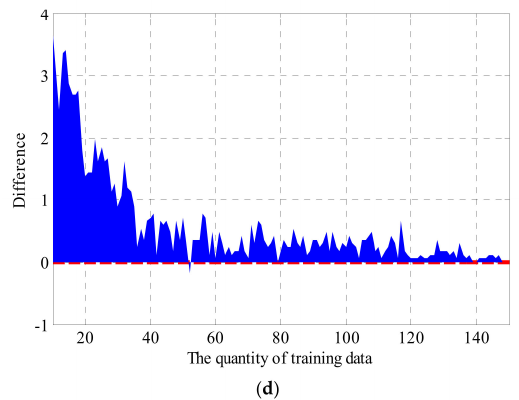
Figure 19. The Overall accuracy (OA) difference of different classification cases: ( a ) case 1: OA difference of 4-category classification for GWC A, B, C and D; ( b ) case 2: OA difference of 2-category classification for GWC A and B; ( c ) case 3: OA difference of 2-category classification for GWC B and C; ( d ) case 4: OA difference of 2-category classification for GWC C and D.